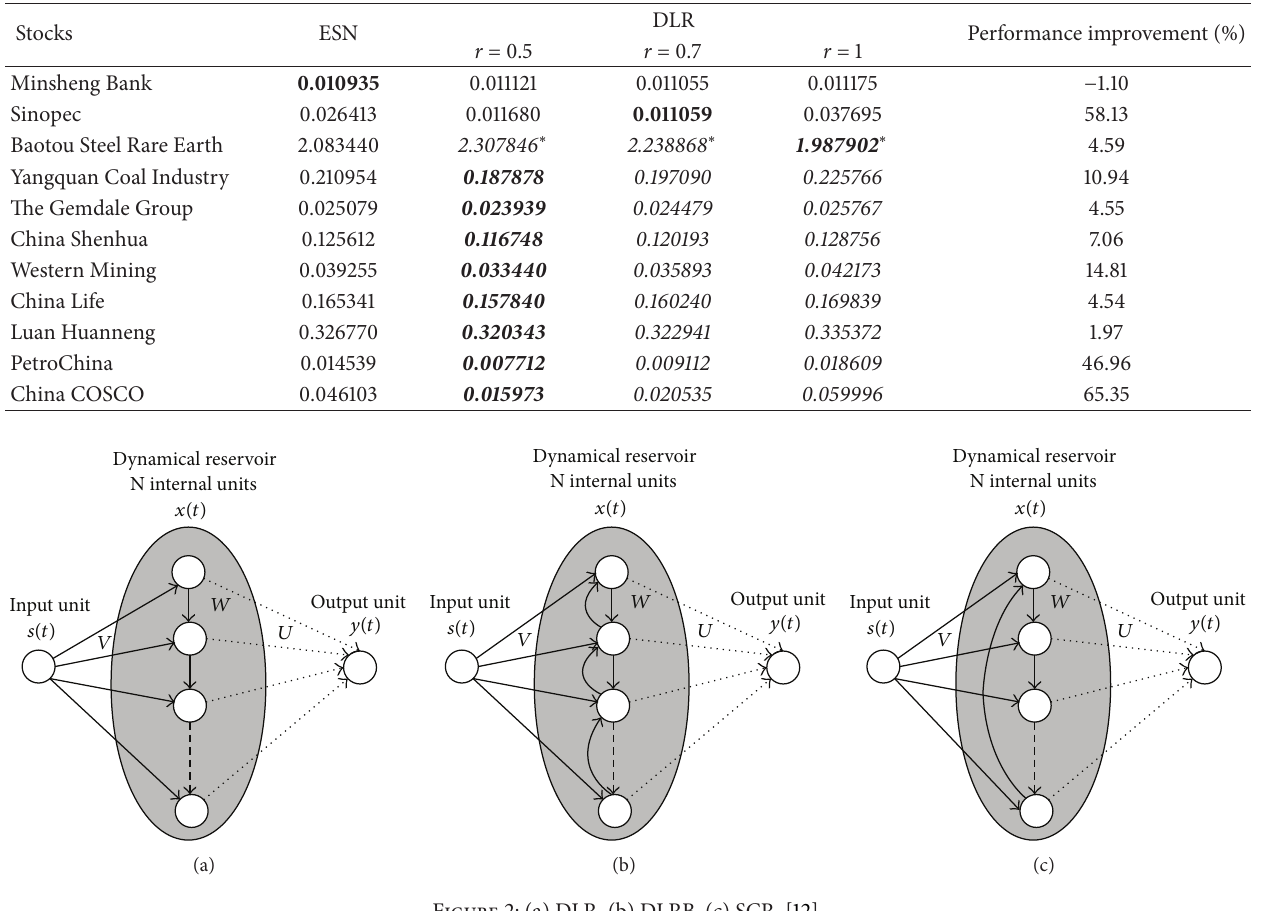
Figure 2: (a) DLR. (b) DLRB. (c) SCR.